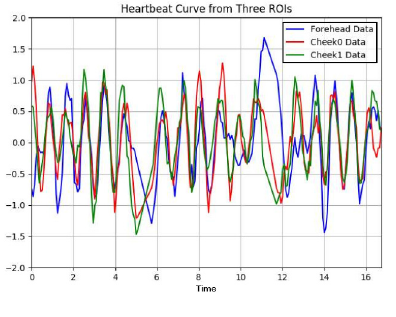
Figure 1. Heartbeat curve of data from different ROIs